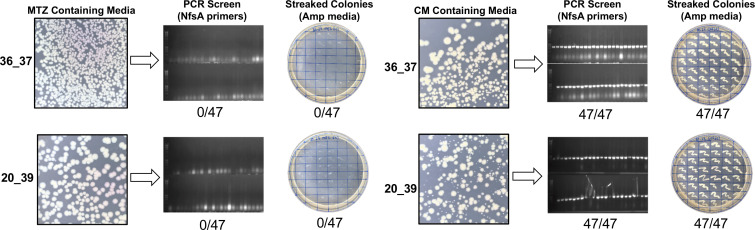
Growth of 36_37 and 20_39 on selective or counter-selective media.An overnight culture of E. coli 7NT cells expressing 36_37 or 20_39 was added at a 1 in 100 dilution to a flask containing unamended LB. The culture was grown at 37°C 200 rpm for 1 hr and then an appropriate dilution was plated over LB agar plates amended with 10 µM metronidazole (MTZ) or 5 µM chloramphenicol (CM). The MTZ plate was incubated at 37°C for 16 hr, while the CM plate was incubated for 40 hr. Forty-seven colonies apiece from the MTZ and CM-containing plates, alongside a negative control (a colony of 7NT cells containing empty pUCX plasmid) were PCR screened with nfsA_Ec specific primers to diagnose presence or absence of the nfsA gene, and also streaked on LB agar media containing ampicillin (Amp) to provide a secondary indication of whether the plasmid bearing the nitroreductase gene was present.